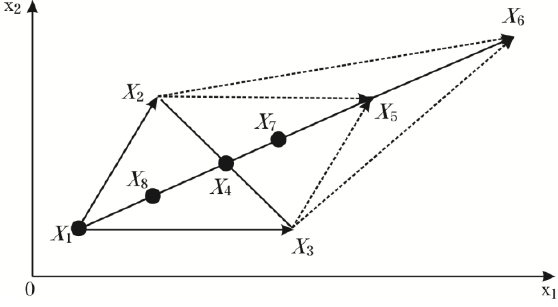
Figure 2. The Simplex Method.